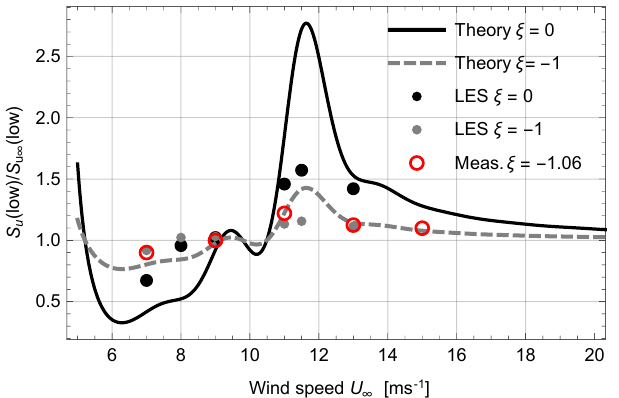
Figure 7. Change in low-frequency ( f < 0 . 03Hz) spectral power of the longitudinal velocity component in the rotor plane and one radius upstream. The dots are the LES simulations, while the lines are the quasi-steady model based on Eqs. (2) and (3). The circles are lidar measurements using Eq. (11) at ξ = − 1 .